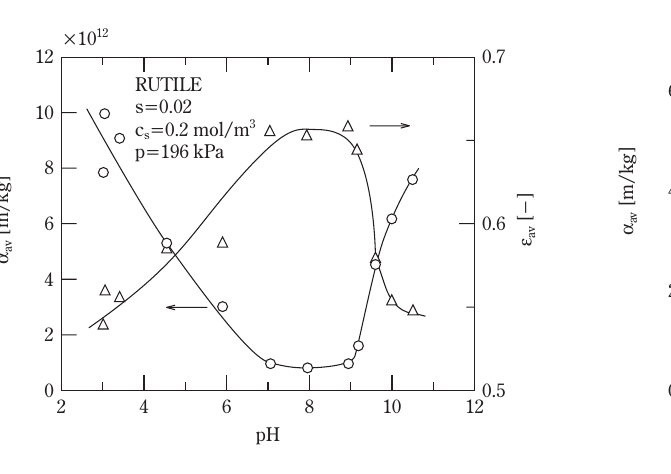
Fig. 16 Effect of pH on average specific filtration resistance and average porosity of filter cake formed in ultrafiltration of BSA